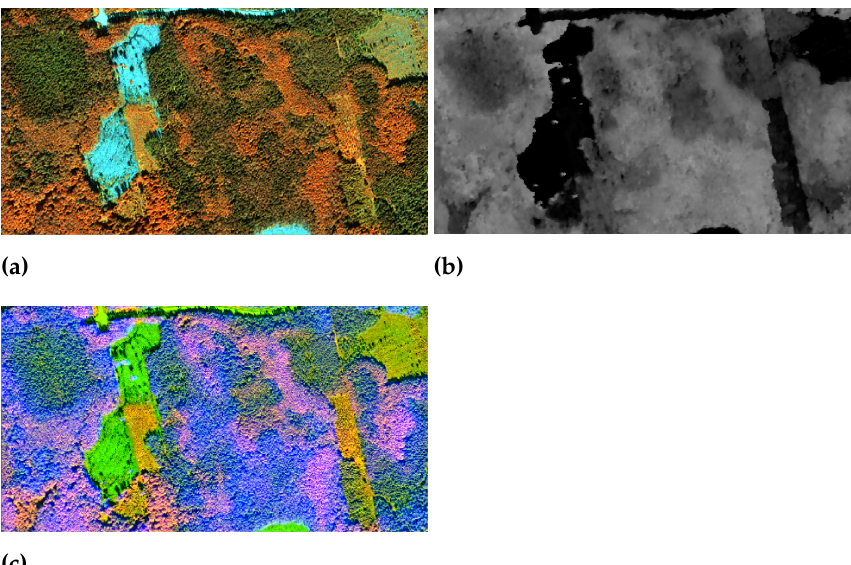
Figure 3. Example of GeoEye-1 data set combinations: a) false-colour MS image (NIR, Green, Blue as image layers), b) CHM derived from the GeoEye-1 scene, c) fused multiband input for GRM (NIR, Green, CHM as image layers).